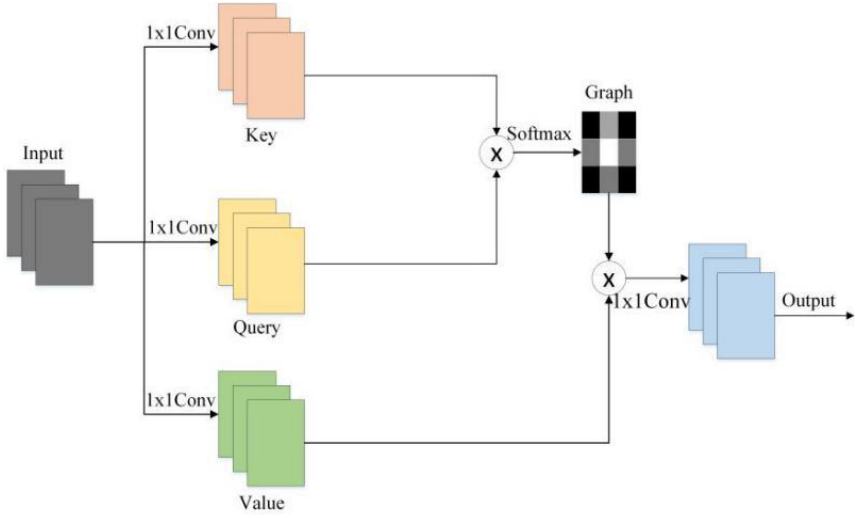
Figure 1. The architecture of self-attention.